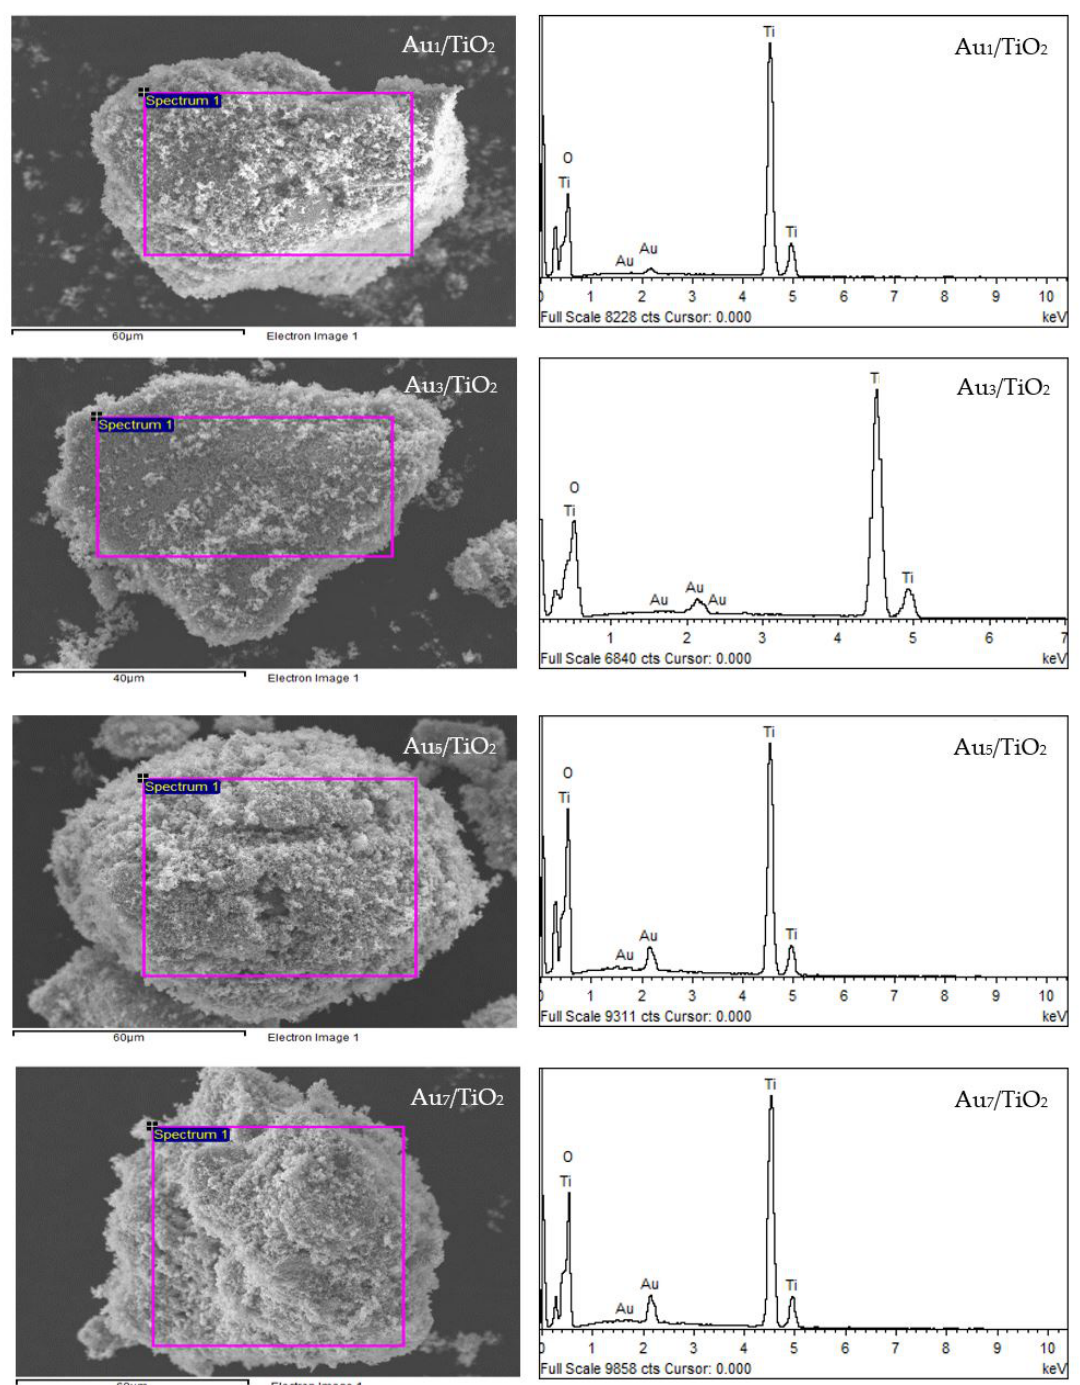
Figure 2. ( Left ) Representative SEM images of the different Au x /TiO 2 photocatalysts and ( Right ) the EDS elemental analysis of the corresponding area shown in the rectangle on the SEM image.